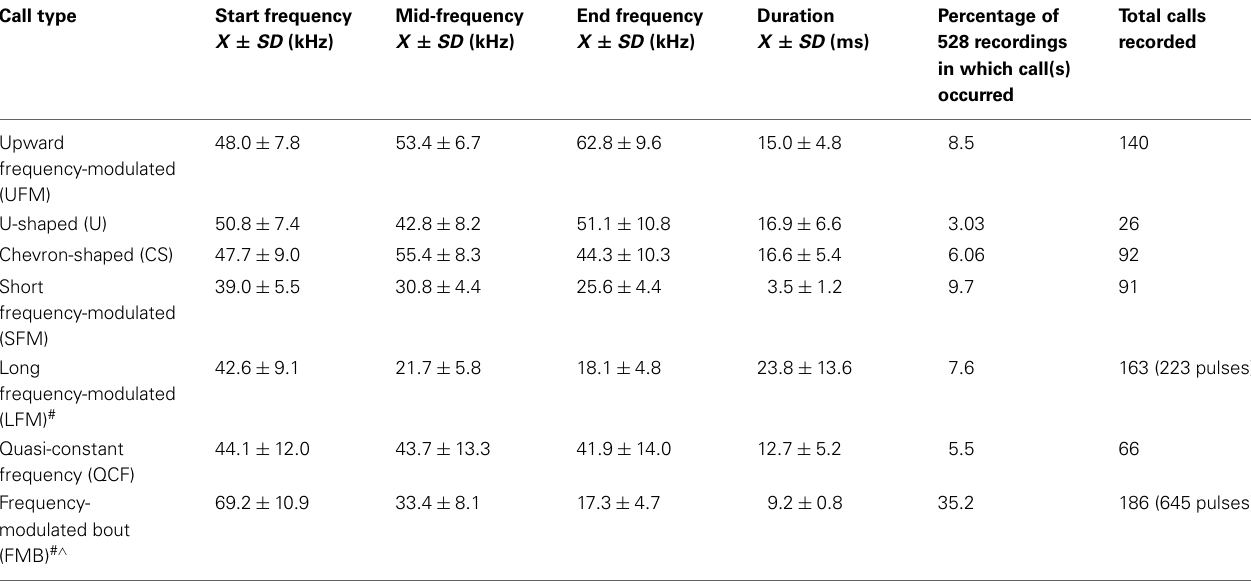
Table 1 | Call parameter values for each call